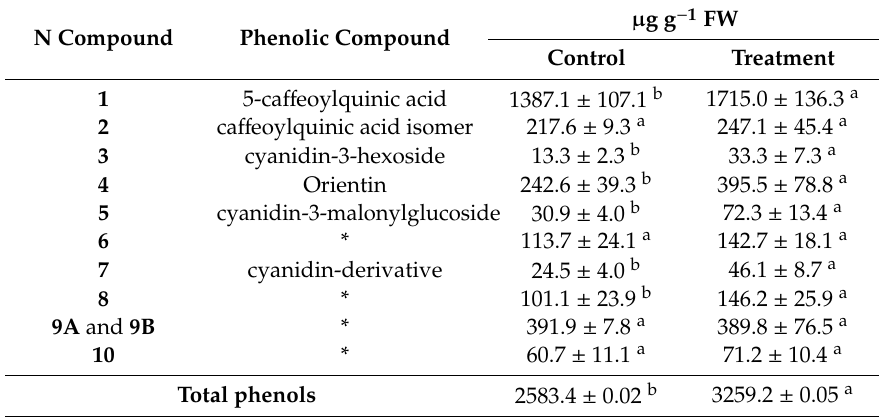
HCADs: Hydroxycinnamic acid derivatives. * Not identified. Table 2. Concentrations of phenolic compounds from Imperata cylindrica shoots by HPLC-DAD. Control condition (without Cu applied) and treatment (300 mg Cu kg − 1